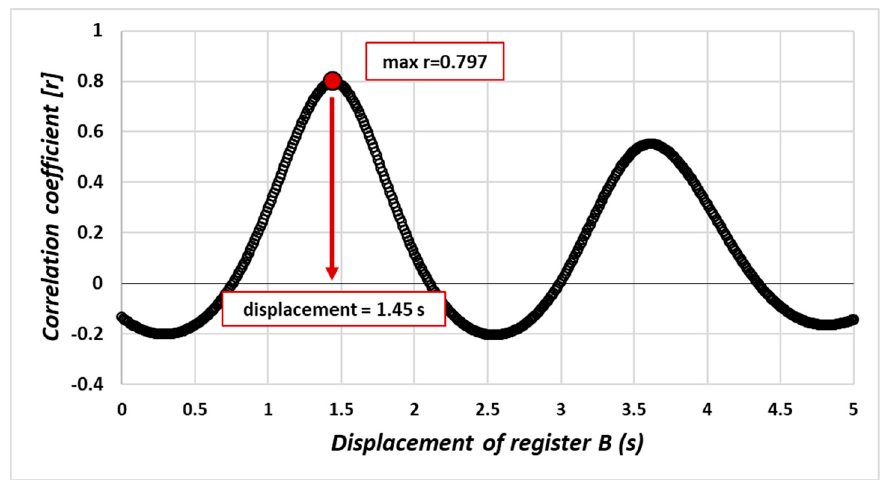
Figure 14. Example of the procedure to determine the travel time between the two measurement points (Test #5).